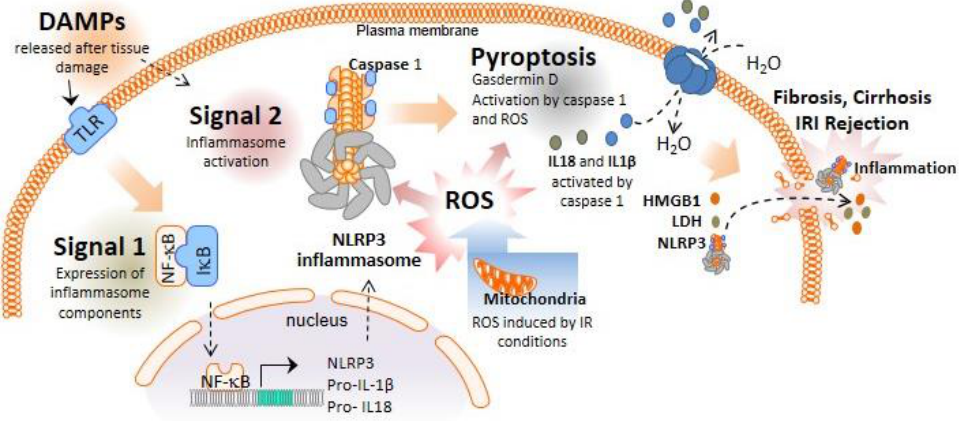
Figure 1. NLRP3 inflammasome and pyroptosis activation during liver inflammation. In the first step of the canonical NLRP3 inflammasome activation, PAMPs and DAMPs stimulate TLR receptors and the translocation of NF- κB to the cell nucleus, which, in turn, increases the transcription of the inflammasome components and expression of pro-IL-1 β and pro-IL-18. A second signal, such as P2X7R activation via ATP or crystalline structures, induces the formation of active NLRP3 oligomers leading to the activation of caspase-1. Caspase-1 cleaves the N- terminus of gasdermin D and converts pro-IL-1 β and pro-IL-18 into mature IL-1 β and IL-18. NLRP3 inflammasome and gasdermin D must be in oxidized form to be active, highlighting the important role of ROS in the regulation of this pathway. Pyroptosis occurs by the insertion of the cleaved gasdermin D N-terminal fragment into the plasma membrane, creating oligomeric pores and allowing the release of proinflammatory mediators such as IL-1 β and IL-18 to the extracellular space. Gasdermin D pores also induce cell lysis which further induces inflammation by releasing additional inflammatory intracellular products.